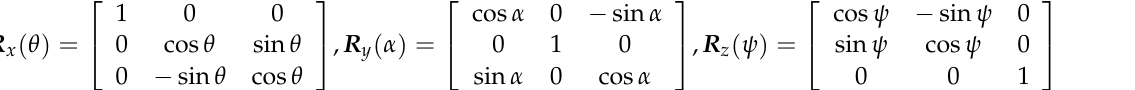
= 0 The solar vector in b-frame ( s b ) calculated by the compound eye polarization sensor, is used to establish the measurement equation. Figure 3 shows the relationship of the main vectors used in solar vector calculation. The polarization angle measured by any monocular polarization unit is represented by α i . The E-vector in m i -frame can be described by